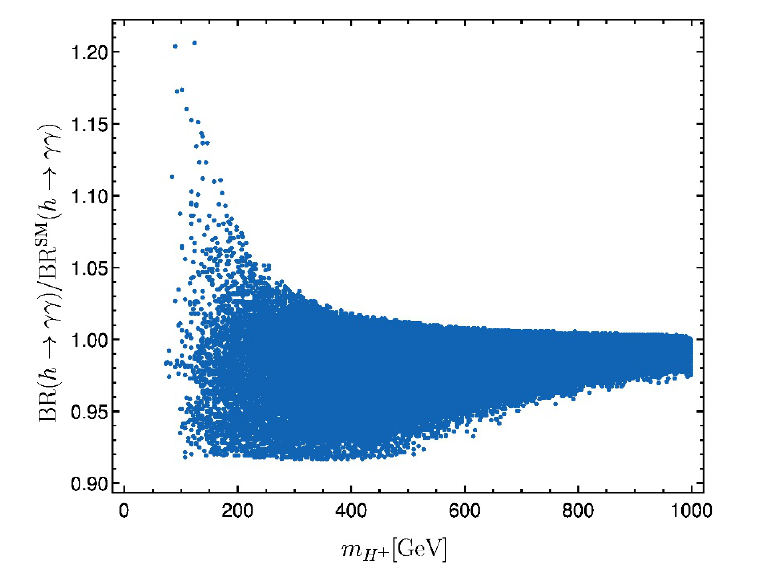
Figure 1. Ratio of the branching ratio of h into two photons to the SM value versus the value of the charged scalar mass for all the allowed points in the